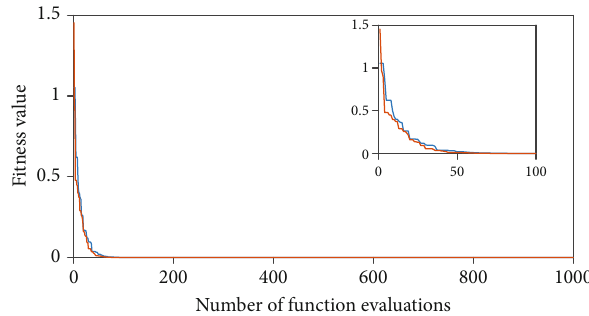
Figure 3: Convergence graph of the parameter optimization